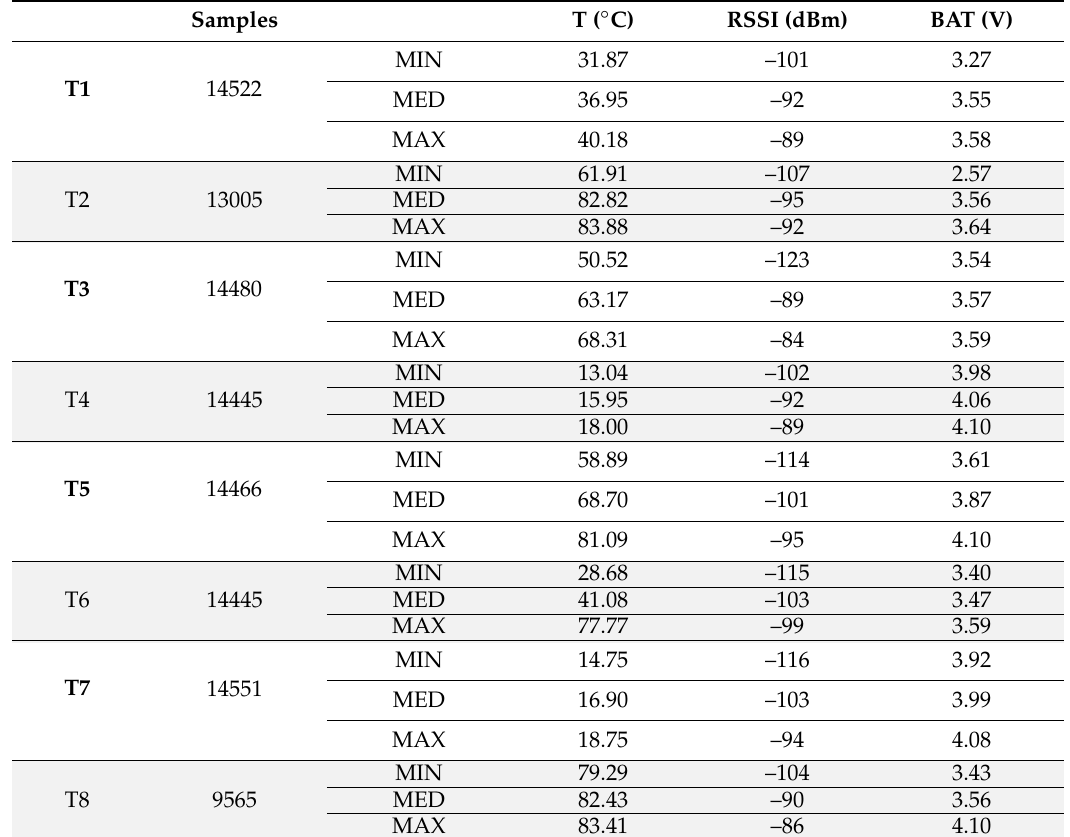
Table 8. Descriptive statistics of the data recorded by the